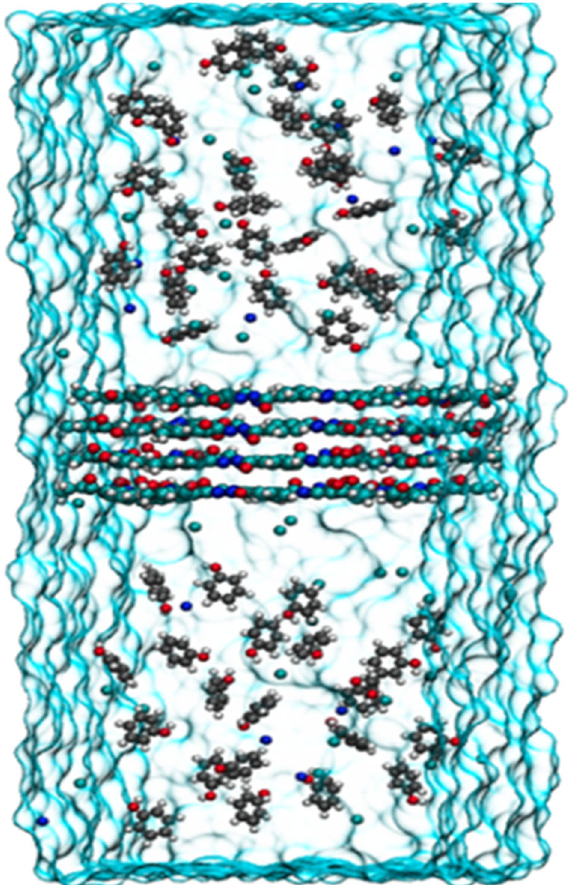
Fig. 9 The initial snapshot of the studied systems. Color code COFs: cyan, phenol: gray, ions: green, and